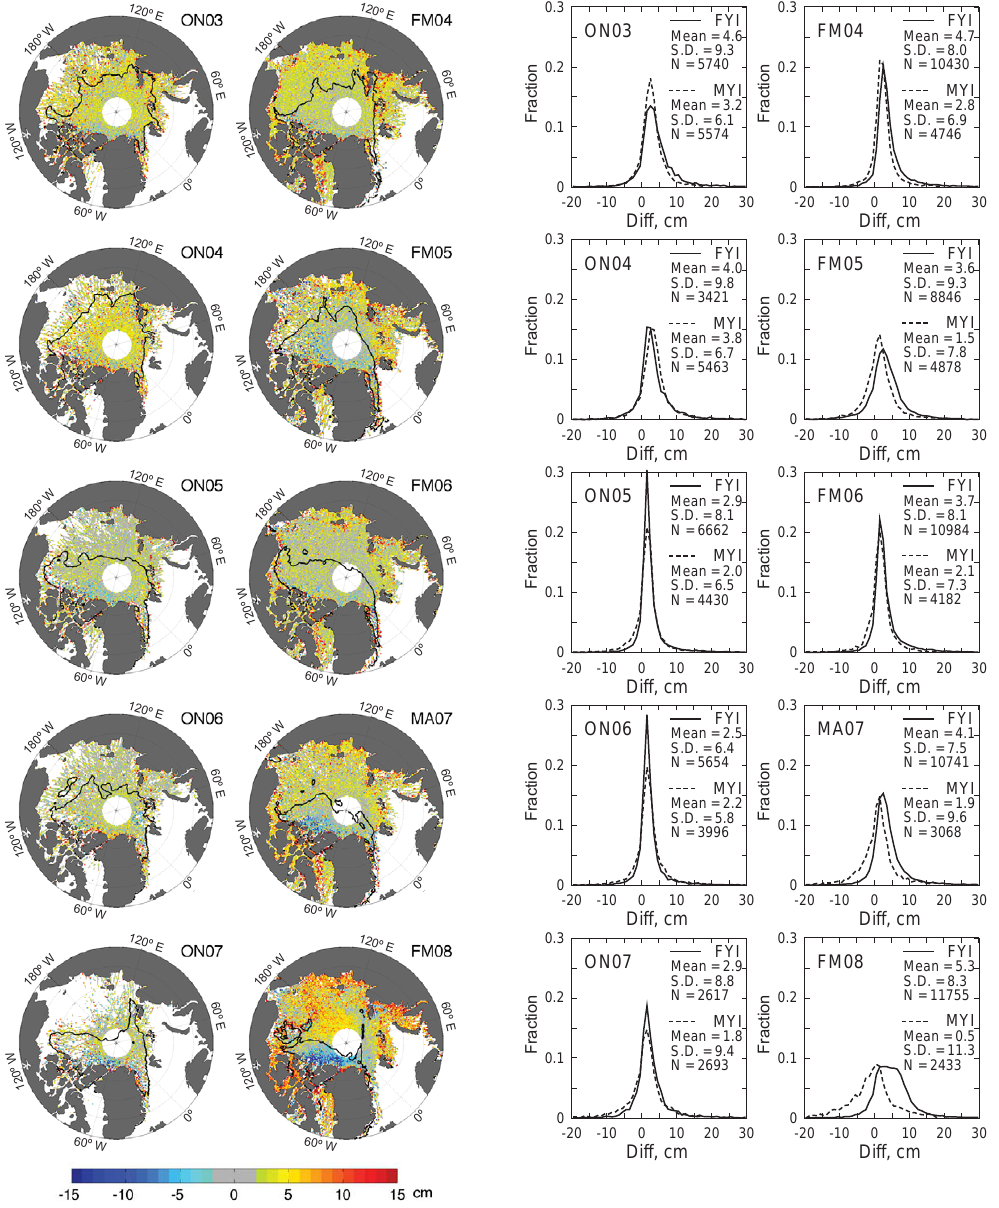
Figure 4. Maps (left) and distributions (right) of the differences between freeboard (25km grids) estimated using LLE and TP methods (LLE minus TP) for 10 ICESat periods (cm). Thick black line on the maps delineates the average 50% isopleth of multiyear ice